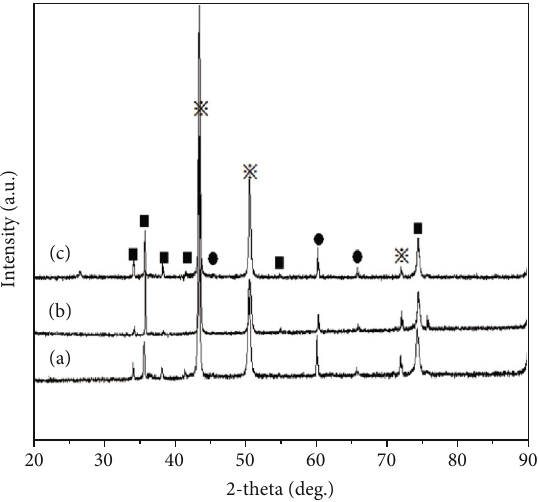
Figure 5: XRD curve of SiC /Cu composites with di ff erent SiC p fractions without magnetron sputtering. (a), (b), and (c) presented the SiC volume fraction with 10%, 30%, and p